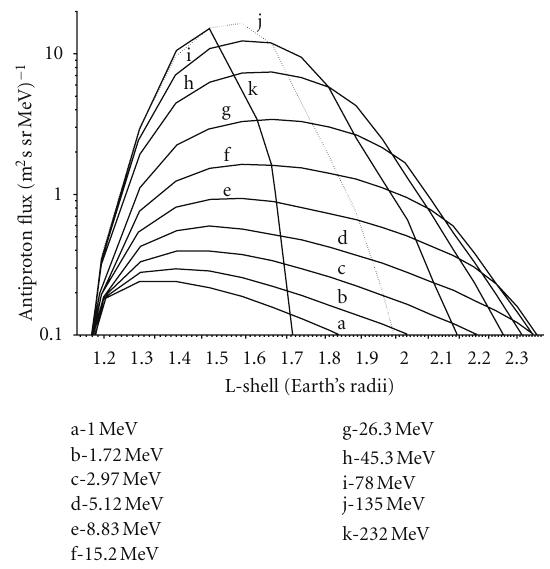
Figure 6: The L -dependence of the trapped antiproton flux spectra for various energies of antiprotons. The horizontal segments of the curves correspond to the direct penetration of the cosmic ray flux to the magnetosphere.